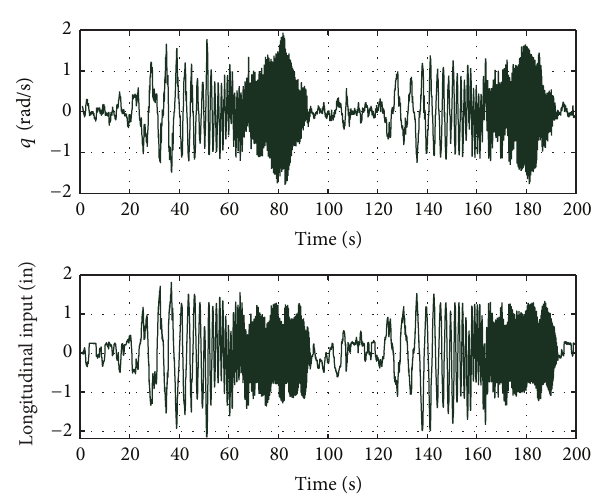
Figure 2: The I/O data of longitudinal channel.